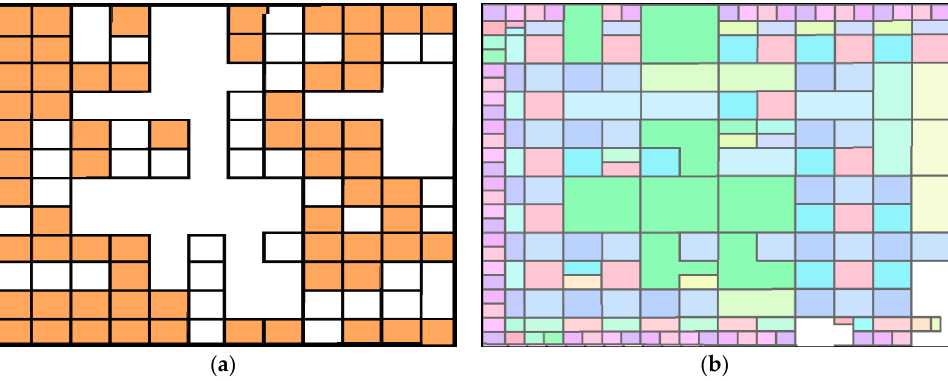
Figure 12. ( a ) Pine Ridge reservation allotment parcels adapted from Dippel et al. [29–31]. ( b ) The same area at Pine Ridge mapped using the new allotment mapping tool described in this study, random color scheme assigned by GIS software.